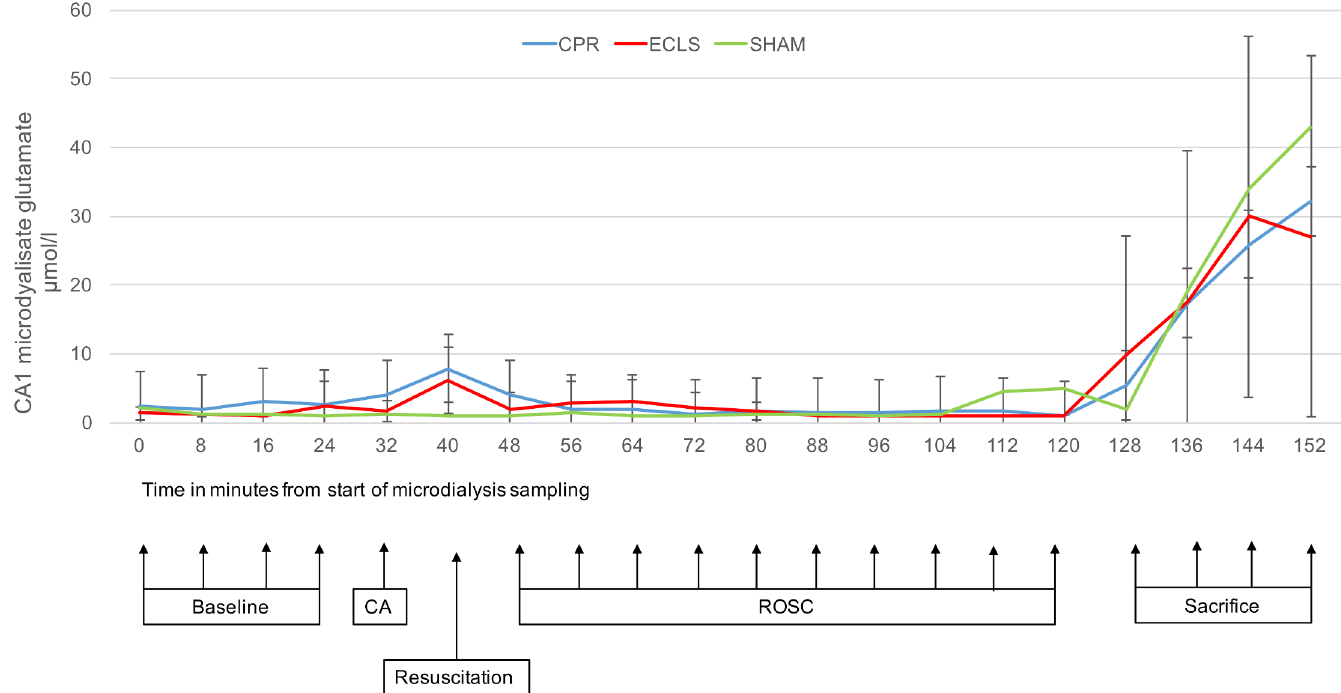
Fig 5. CA1 glutamate μ mol/l against time. x-axis: Point of measurement, measurements 8min apart (sampling interval of 8min); y axis: Glutamate ( μ mol/l; mean values and standard deviation); CA, cardiac arrest; CPR, cardiopulmonary resuscitation; ECLS, extracorporeal cardiopulmonary life support; BL, baseline; ROSC, return of spontaneous